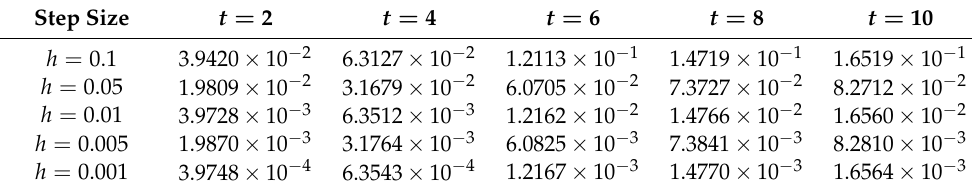
Table 3. Computation error of the time domain response of IFOTF